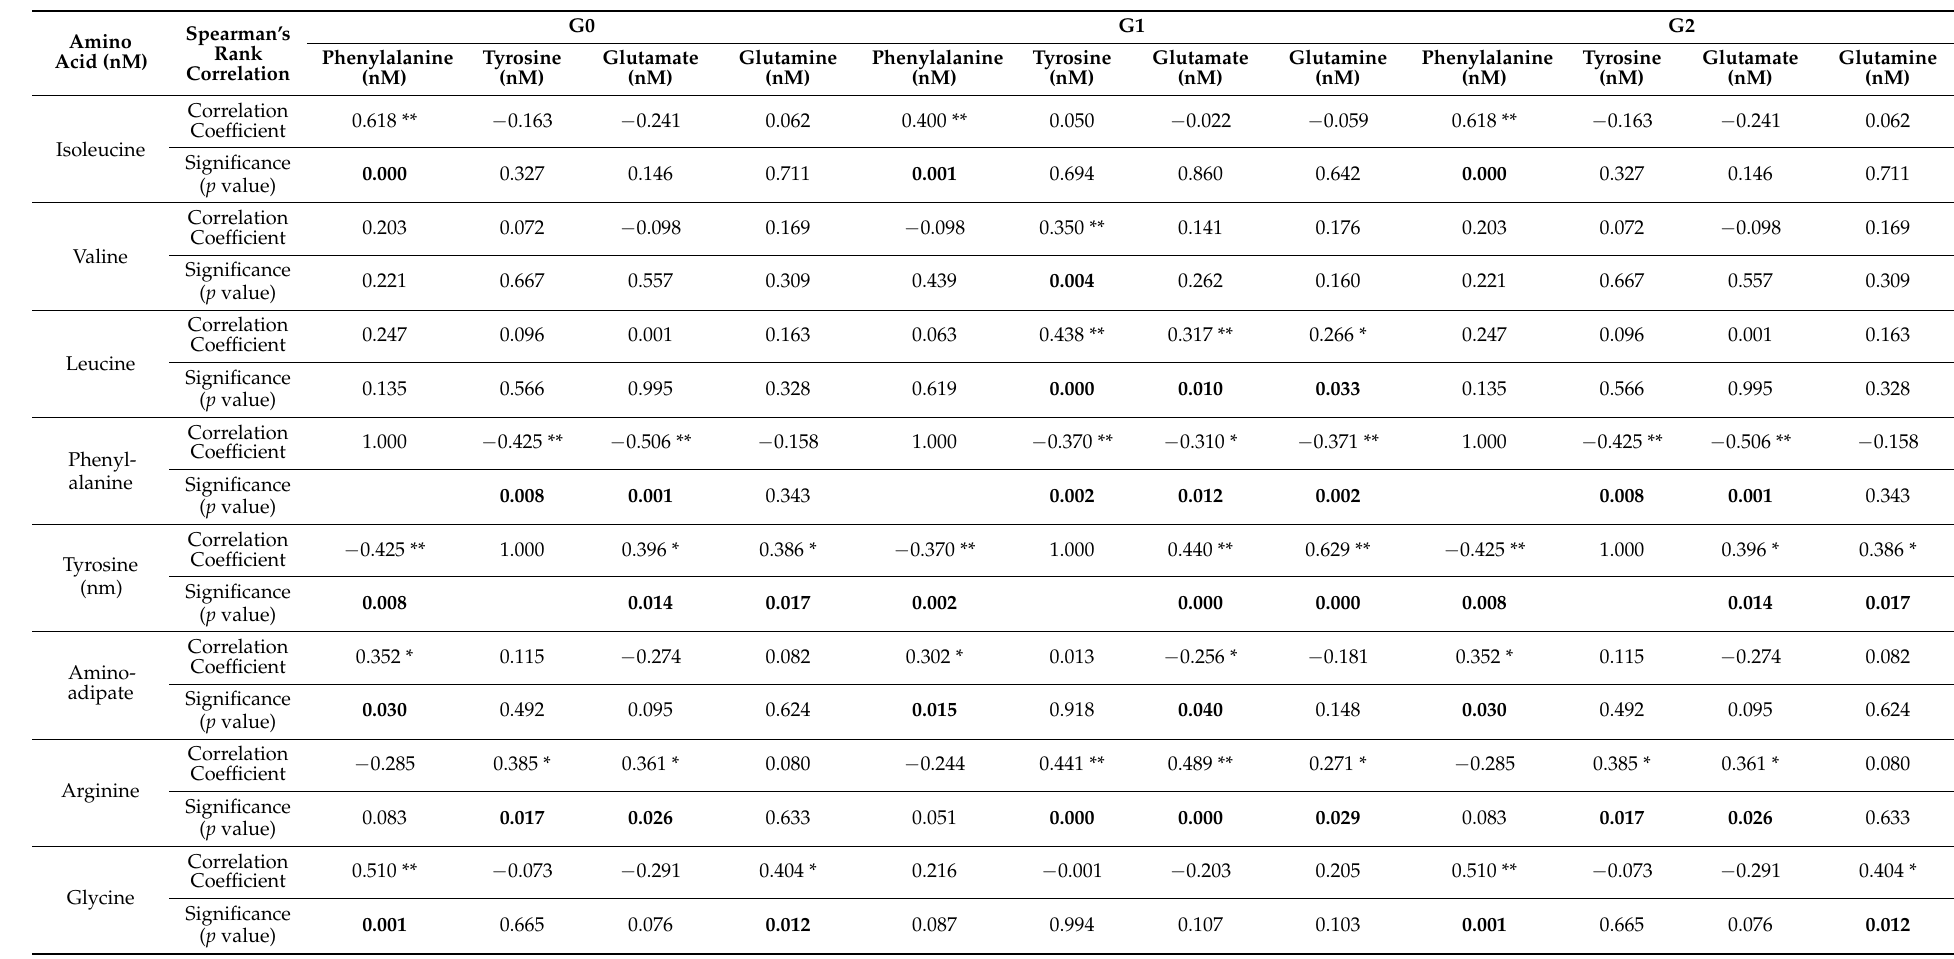
Table 3. Correlation coefficient (r) and significance ( p ) using the spearman’s rank correlation test for healthy controls (G0), single-treated (G1) and multi-treated (G2) type 2 diabetes mellitus groups for the Aromatic amino acids (AAA), glutamate and glutamine. * Correlation is significant at the 0.05 level (2-tailed); ** Correlation is significant at the 0.01 level